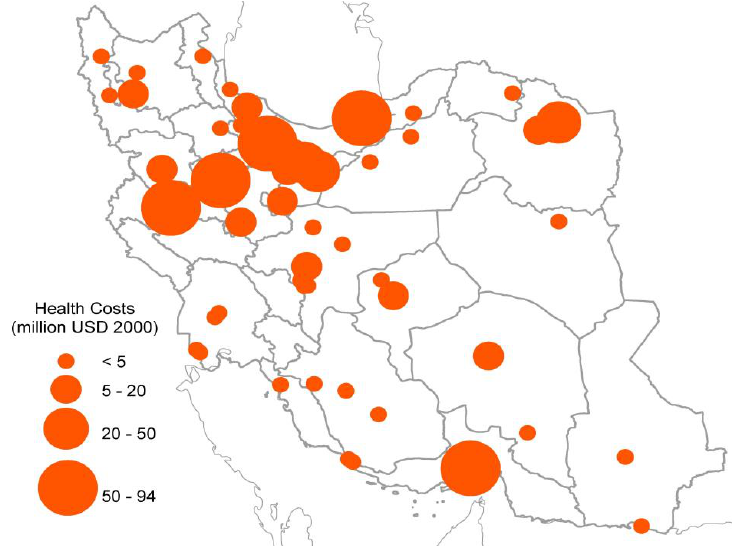
Figure 9. Distribution of total health costs from all 61 power plants in Iran.